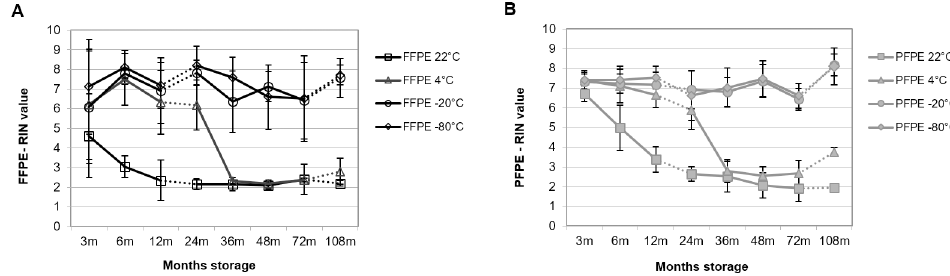
Fig 3. RNA integrity from rat PET blocks decrease depending on storage temperature. For each of five different tissue types (liver, kidney, spleen, lung and intestine) and four different temperatures (22˚C, 4˚C, -20˚C, and -80˚C) 3 blocks of FFPE and PFPE rat tissue were stored. RNA was extracted from block 1 after 3, 6 and 12 months (m), from block 2 after 24, 36, 48 and 72 m and from block 3 after 108 m of storage. Mean RNA integrity number (RIN) values with standard deviation from FFPE (A) and PFPE tissue (B) are shown for triplicate extractions from five different tissue types for each fixation method, storage time point and temperature (total RIN values n = 942). Dotted line indicates block